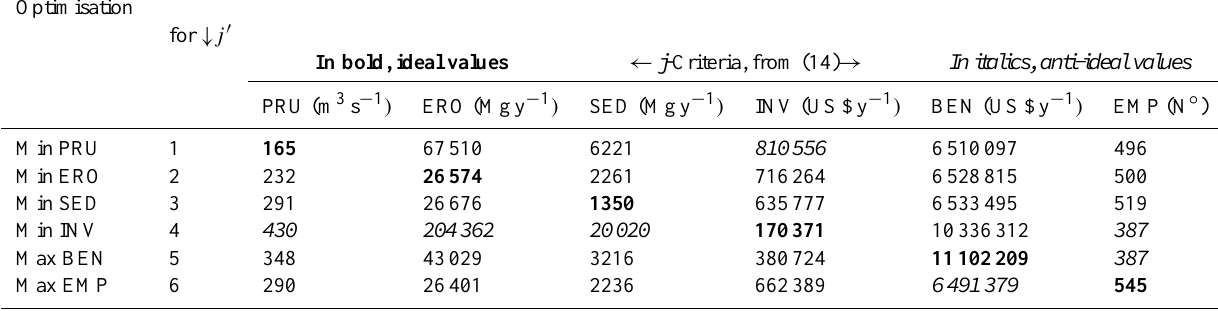
Table 2. Pay-off matrix PM or for the criteria of the La Colacha case study. To obtain each j 0 -line, the CV vb j 0 was optimised, getting values. In diagonal, in bold, best j -ideal values; in j -column, in italic, worse j -anti-ideal value.